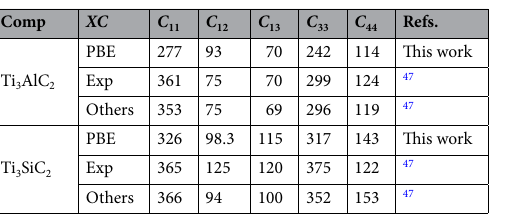
Figure 3. Calculated PDOS of ( a ) Ti 3 SiC 2 and ( b ) Ti 3 AlC 2 MAX phases.